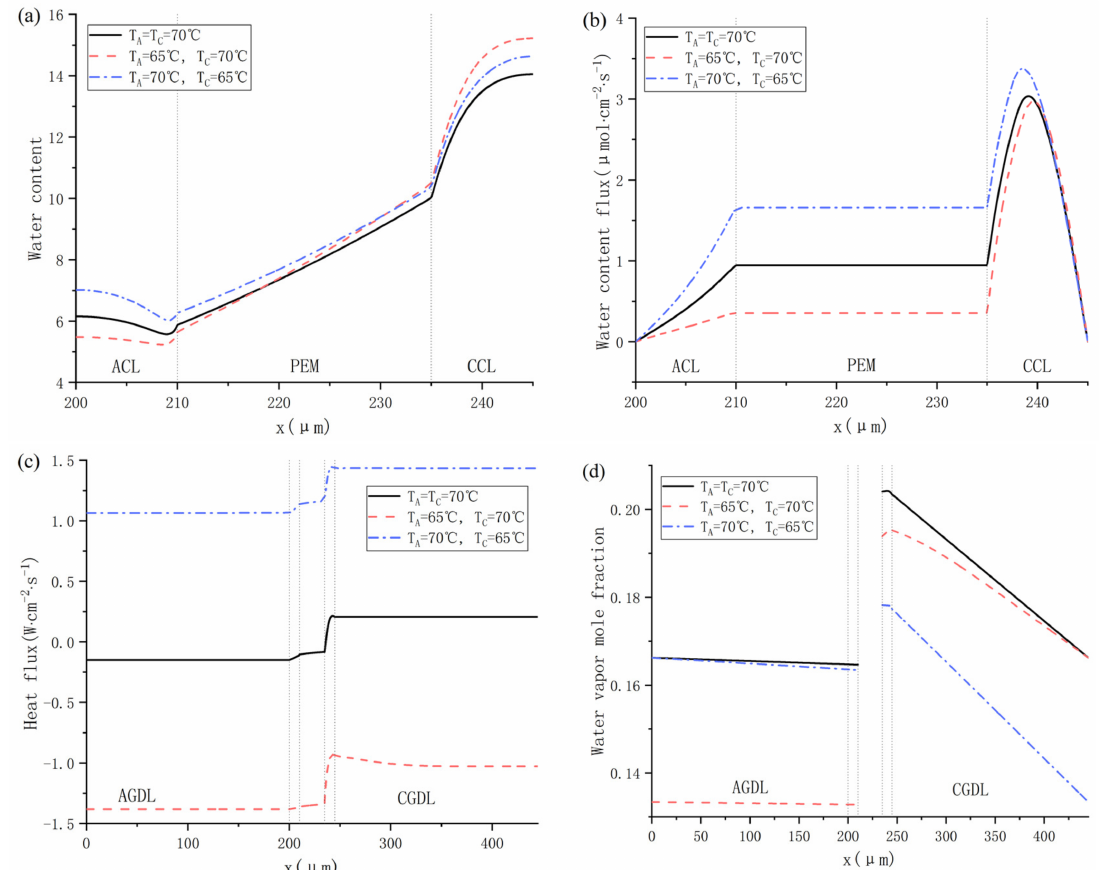
Figure 13. Water distribution at different gas inlet temperature of cathode and anode: ( a ) water content: ( b ) water content flux; ( c ) heat flux; and ( d ) water vapor mole